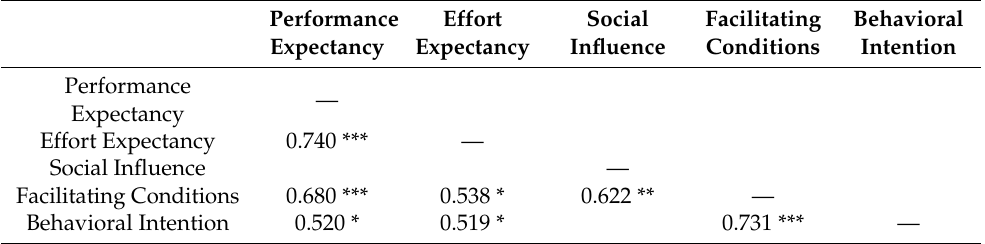
Table 5. Correlation Matrix UTAUT dimensions—SHERPAM project D + 21. Performance